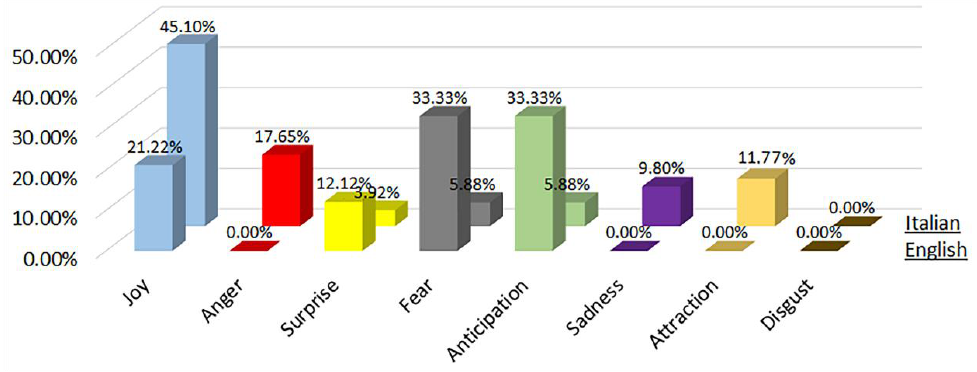
Figure 14. Percentage distribution of every primary emotion for English and Italian words of the 3 phases during COVID-19 pandemic.